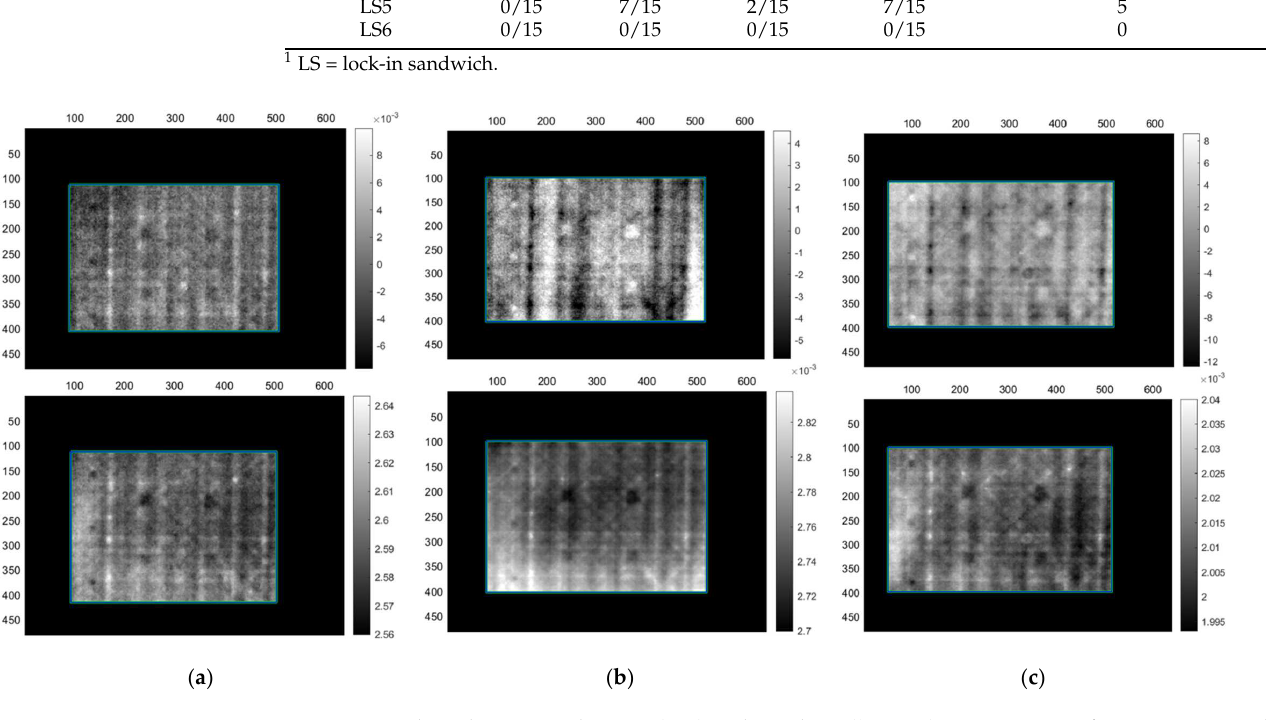
Figure 8. Lock-in thermography PCT (top) and FT phase (bottom) mirror images from inspection of the CF-PET-CF sandwich sample. ( a ) Images from acquisitions LS1, ( b ) LS2 and ( c ) LS5. Table 11. Optical lock-in results from the inspection of the CF-PET-CF sandwich sample. Acquisition No.